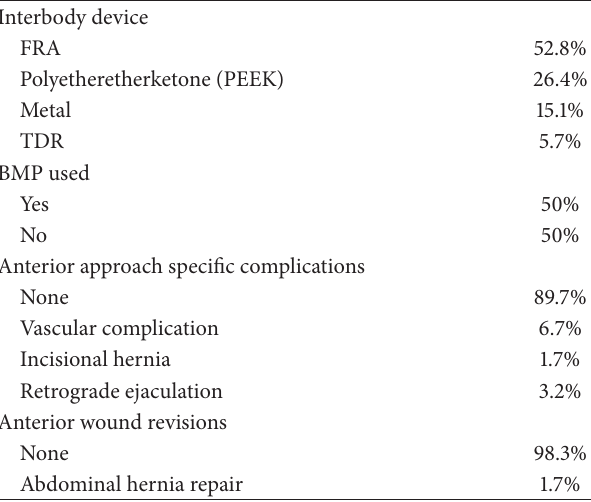
Table 2: Intraoperative patient characteristics.